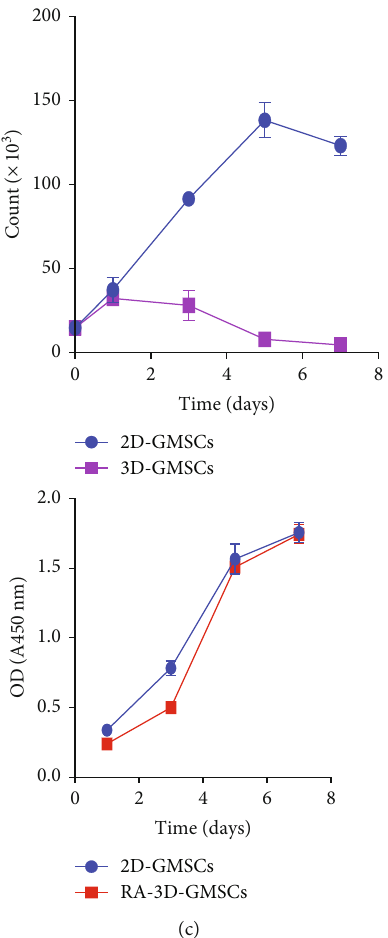
Figure 1: Characterization of GMSCs. (a) Representative images of 2D cultured GMSCs (A). Morphology of GMSCs cultured on a low attachment culture dish (B). Representative images of adipogenesis (C) and osteogenesis (D). (b) Flow cytometric analysis of surface markers in GMSCs under 2D or 3D conditions. (c) Proliferation assay for GMSCs cultured on a low attachment culture